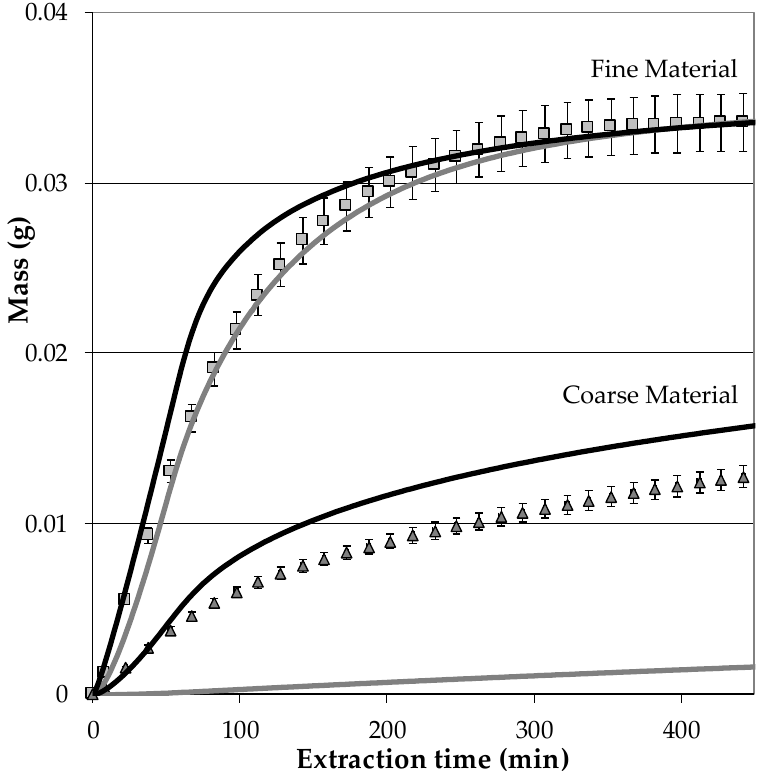
Figure 10. Extraction progress, simulation (continuous lines), and experiments (points) for two different particle size distributions, (black line: simulation with PSD and grey line: simulation with mean particle diameter).